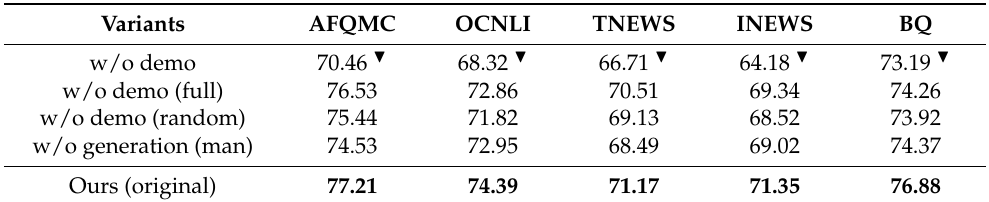
Table 4. Ablation study results of our proposal on 5 datasets. The results of the best performer in each column are bolded. The biggest drop in each column is appended with